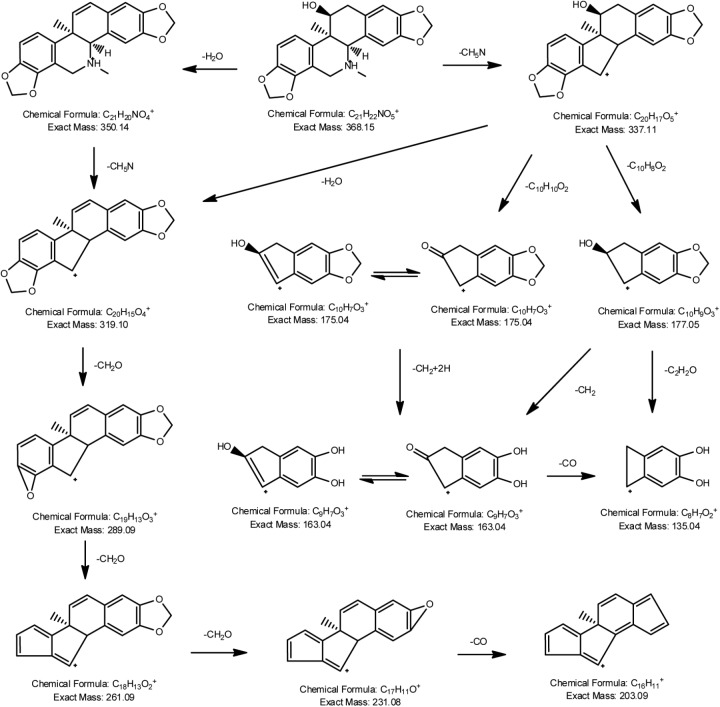
Proposed fragmentation pathways of corynoline.